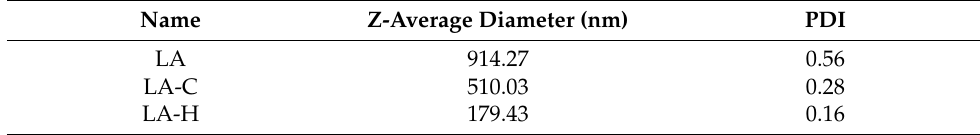
Figure 1. Particle size of processed adjuvants. LA: L. acidophilus particles. LA-C: LA particles treated with high-pressurized homogenization (HPH). LA-H: LA particles treated with HPH with addition of trehalose and emulsifiers. Table 1. Z-average diameter and polymer dispersity index (PDI) of